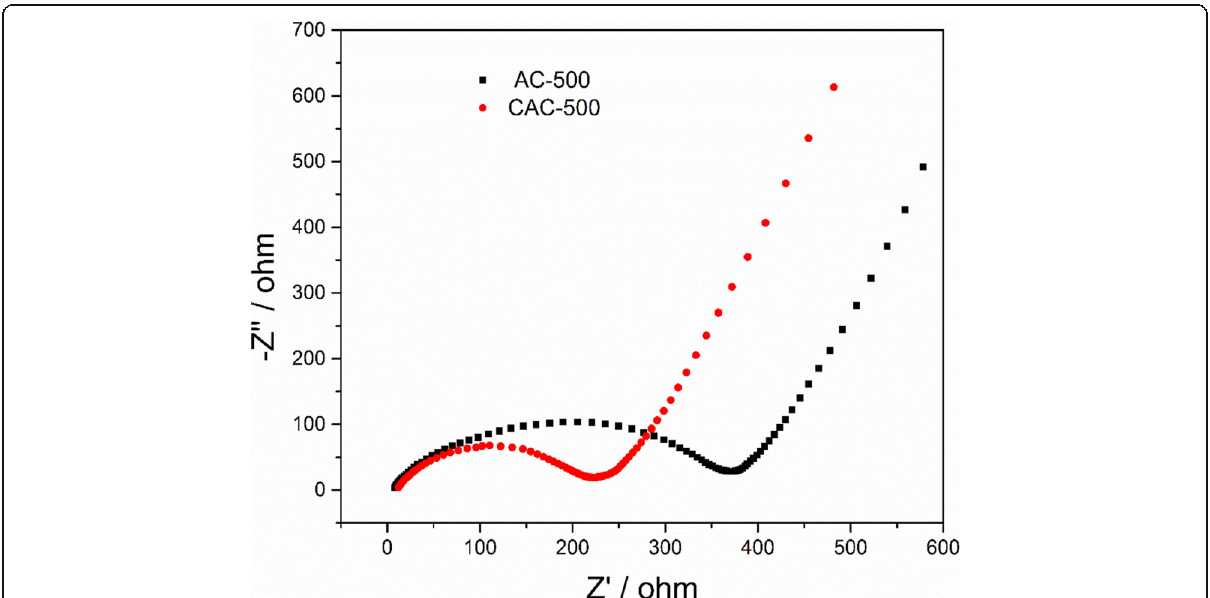
Fig. 8 Impedance spectrums of AC-500 and